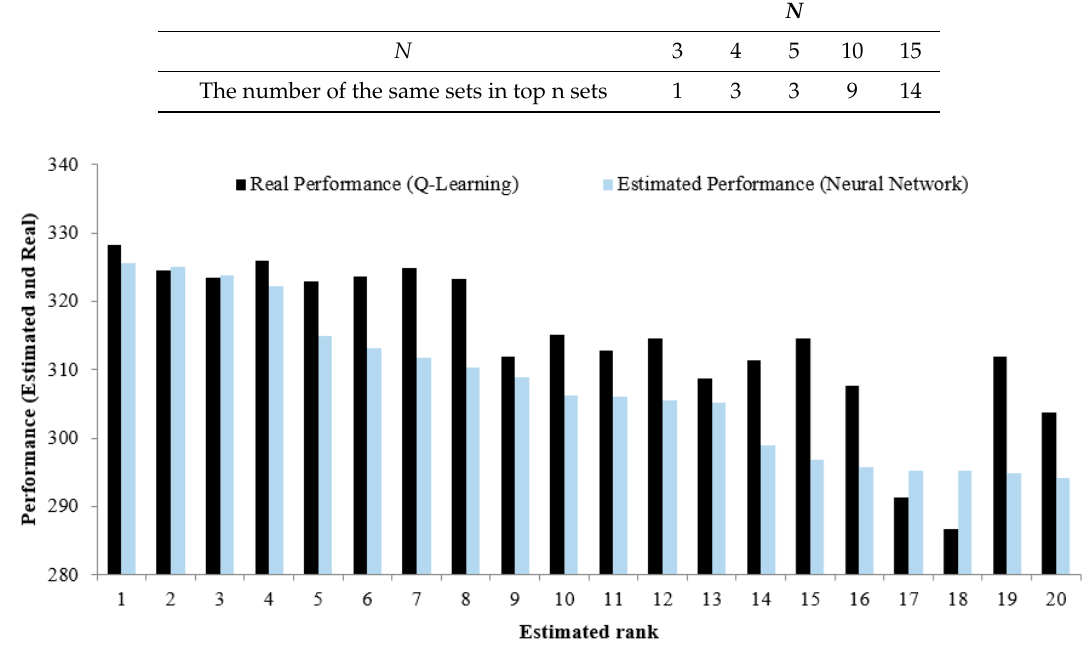
Figure 8. The estimated and real performance of top 20 sets based on estimated performance.